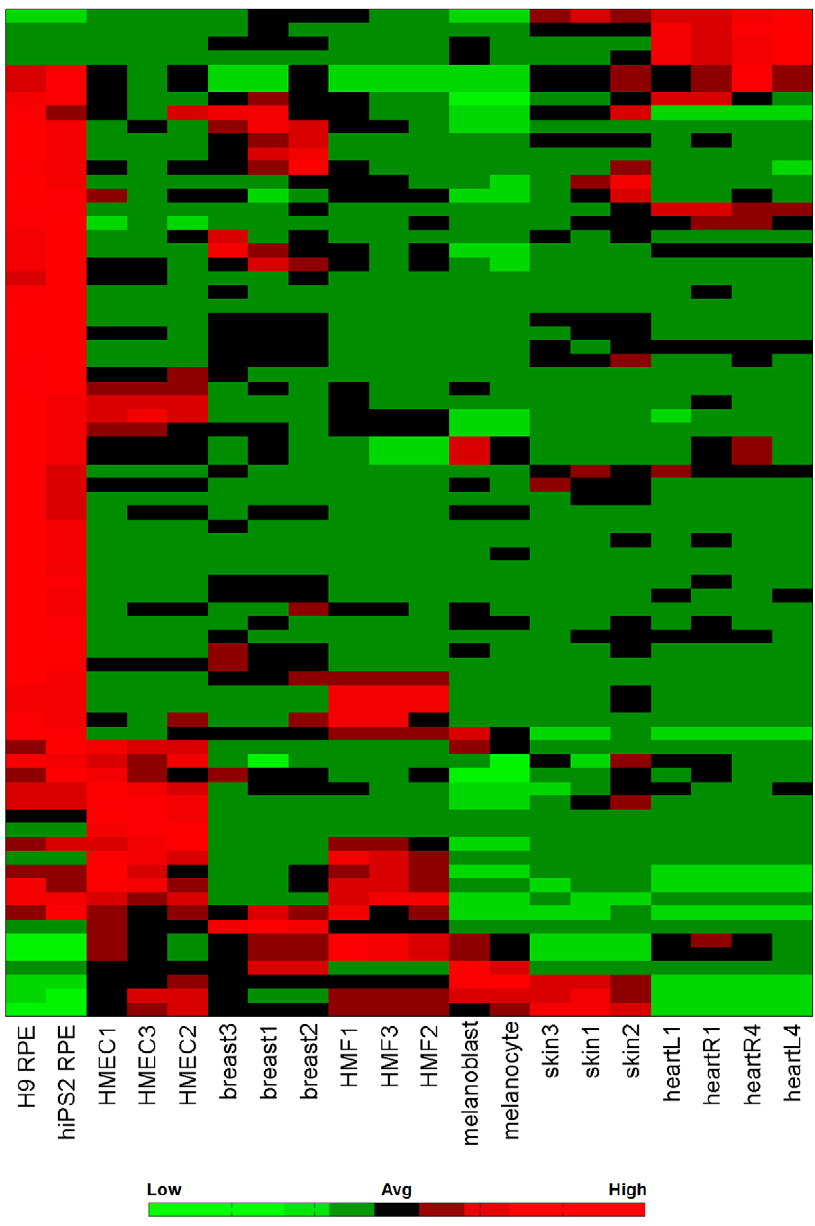
Figure 3. RPE-specific miRNA expression. Heatmap representing all miRNAs that are significantly up- or down-regulated compared to other somatic tissues.